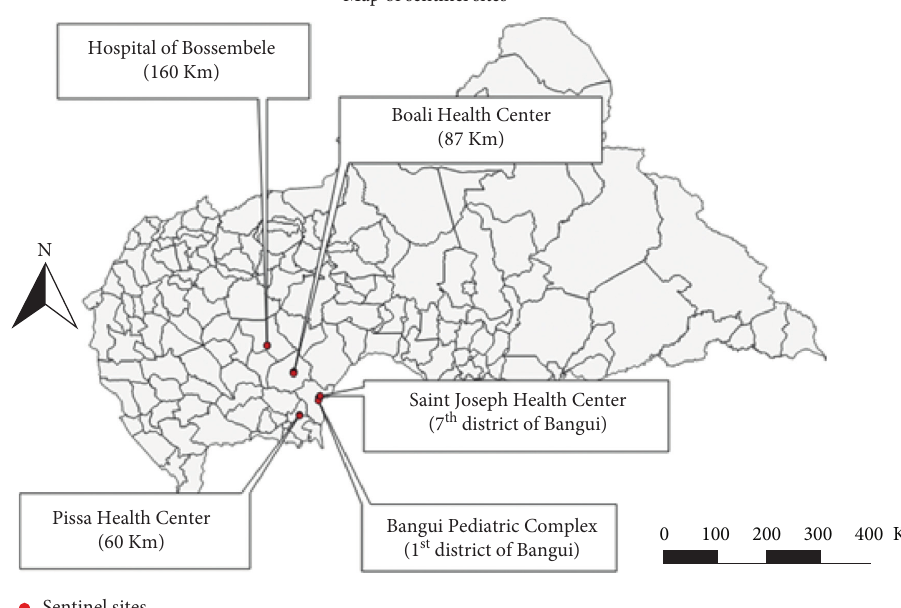
Figure 1: Map of sentinel sites for surveillance of influenza-like illness, Central African Republic,